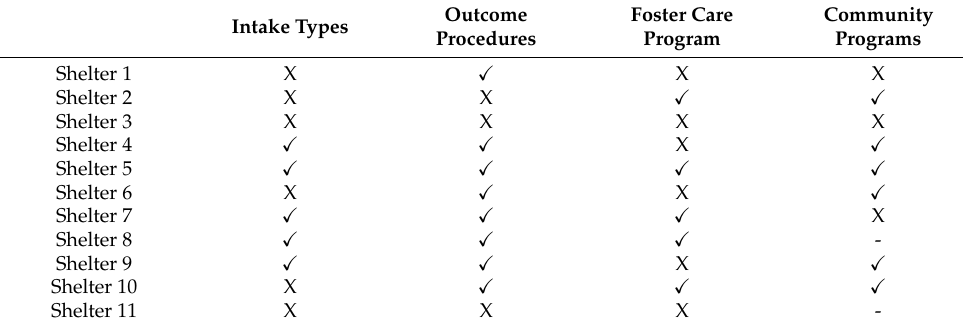
Table 3. Shelter operations relative to